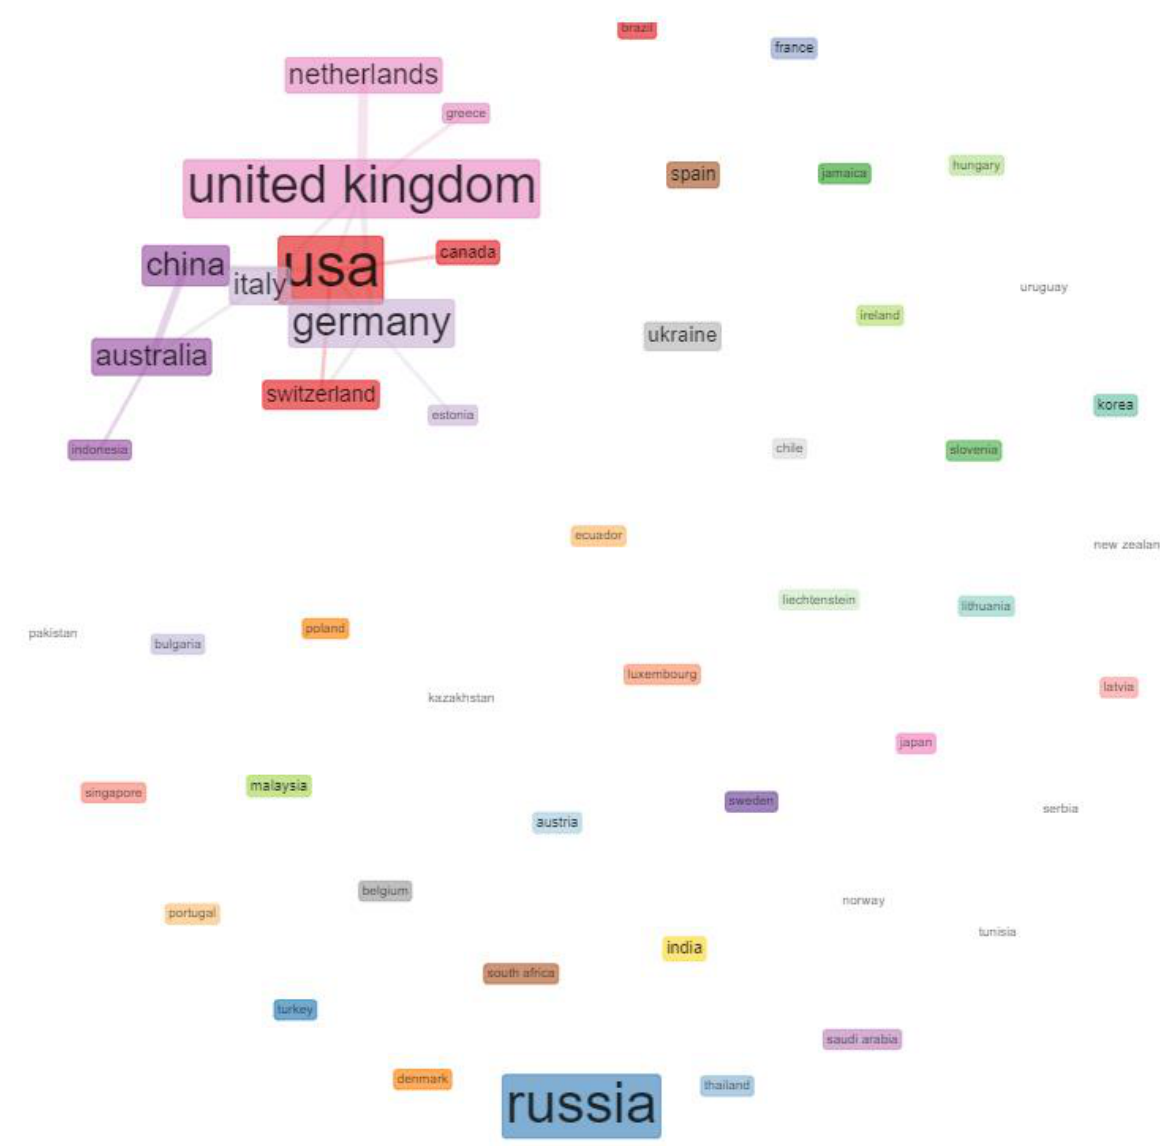
Figure 6. Social structure: collaboration network (countries). Clustering algorithm: Louvain, min edges (2), number of labels (5–50) and number of nodes (5–50).